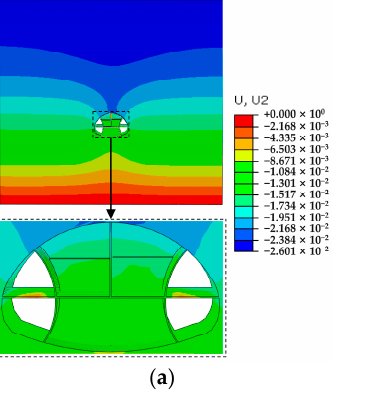
Figure 4. The vertical displacement of surrounding rock from excavation to target section (unit: m): ( a ) Condition 1; ( b ) Condition 2; and ( c ) Condition 3.